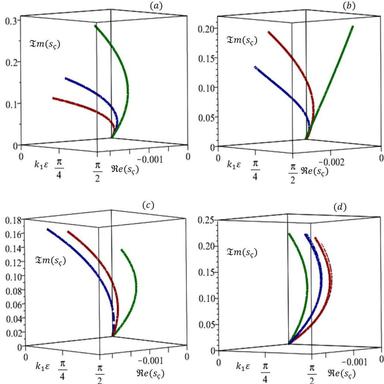
Dispersion functions associated to shear waves travelling along e1. Comparison between the homogenized model 1 (continuous line) and homogenized model 2 (dotted line); (a) is obtained by setting τ 1 ς = τ 2 ς = 2, η = 1, rρ = rE = 10, ν˜1 = ν˜2 = 0.2 and by varying the dimensionless elastic parameter γ = 1/30 (red curves), γ = 1/10 (blue curves) and γ = 1/5 (red curves); (b) is obtained by setting η = 1, rρ = rE = 10, ν˜1 = ν˜2 = 0.2, γ = 1/10 and by varying the dimensionless relaxation time τ 1 ς = τ 2 ς